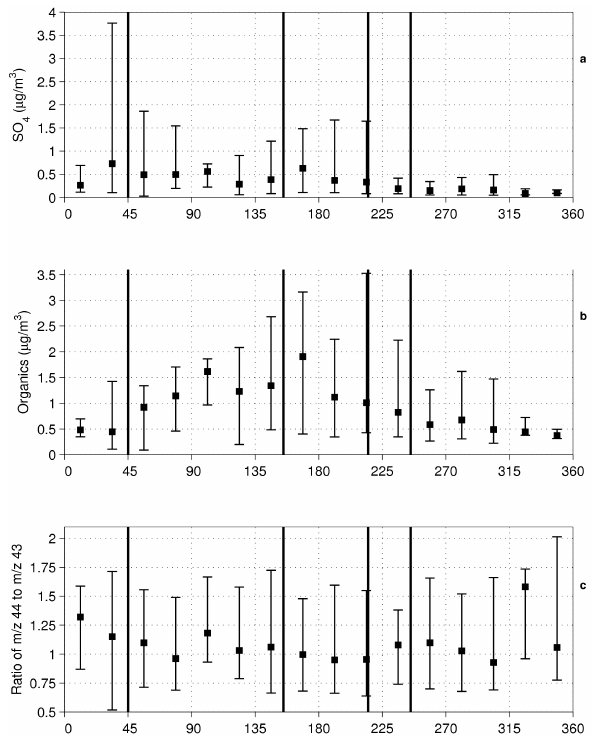
Fig. 7. 741 Fig. 7. The 10th percentile (lower error bar), median (square), and 90th percentile of (a) sulphate concentration, (b) organics concen- tration, and (c) the ratio of mass numbers 44 to 43 in non-refractory submicron particles as a function of wind direction at Puijo, aver- aged over the time period of 16 September–20 October 2008. The vertical lines are the limits for the geographical sectors for local source